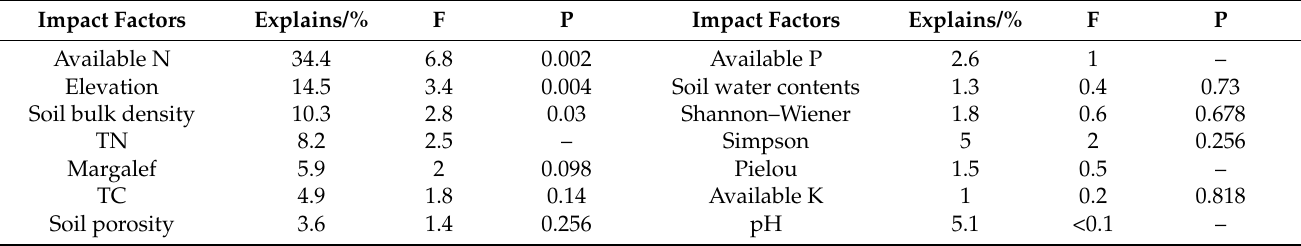
Table 5. Explanation of the impact factors in the redundancy